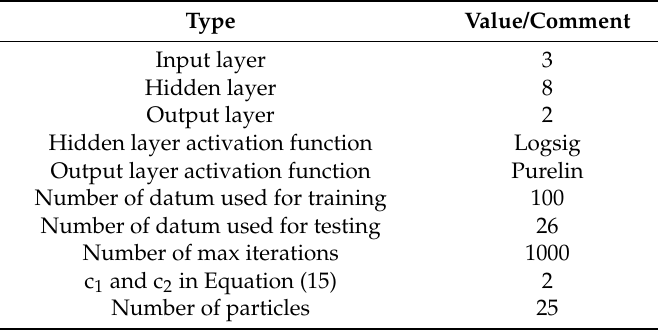
Figure 2. Flowchart of the Particle Swarm Optimization (PSO)-based optimization algorithm for evolving the weights and biases of the constructed artificial neural networks (ANN). Table 1. Details of trained ANNs with PSO for the prediction of viscosity and thermal conductivity of Fe 2 O 3 /ethylene glycol-water